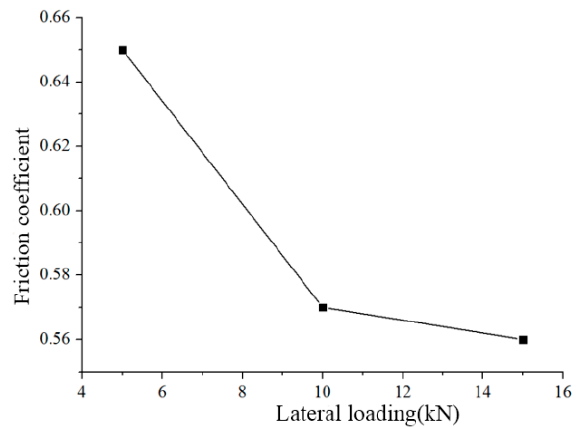
Figure 16. The experimental device. In order to solve the strain of the clamp under the load, select the strain value of the dangerous area of the clamp [31,32], as shown in the Figure 17.